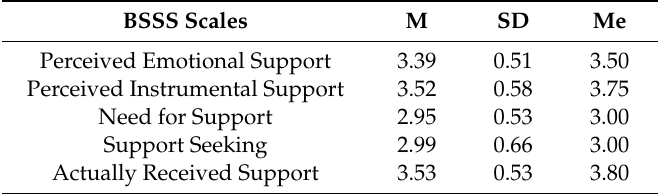
Table 3. Berlin Social Support Scales (BSSS) in the hyperglycemic pregnant women